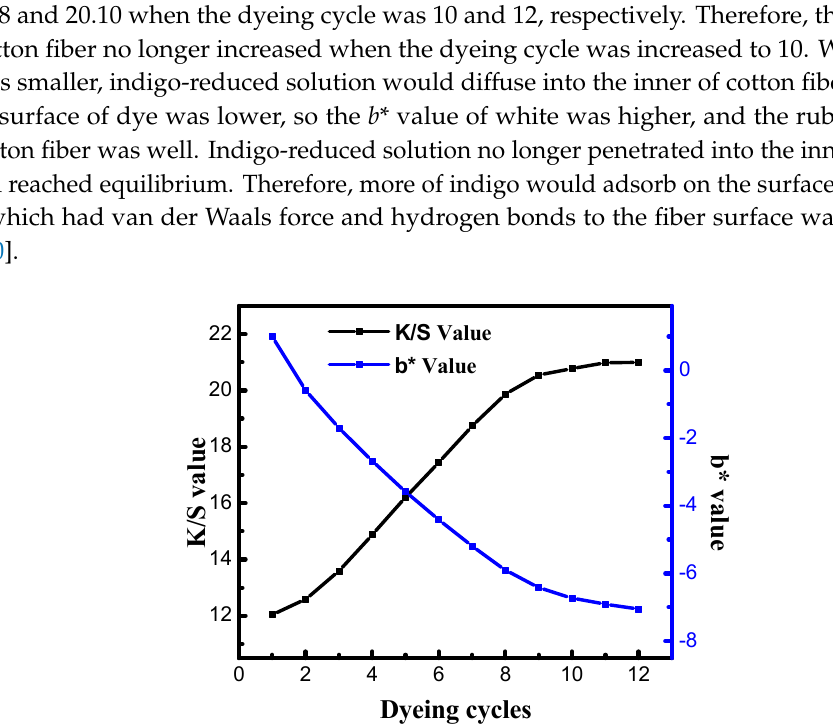
Figure 2. K / S value of dyed cotton fiber and b * value of stained white fabric for indigo dyeing in traditional water base.